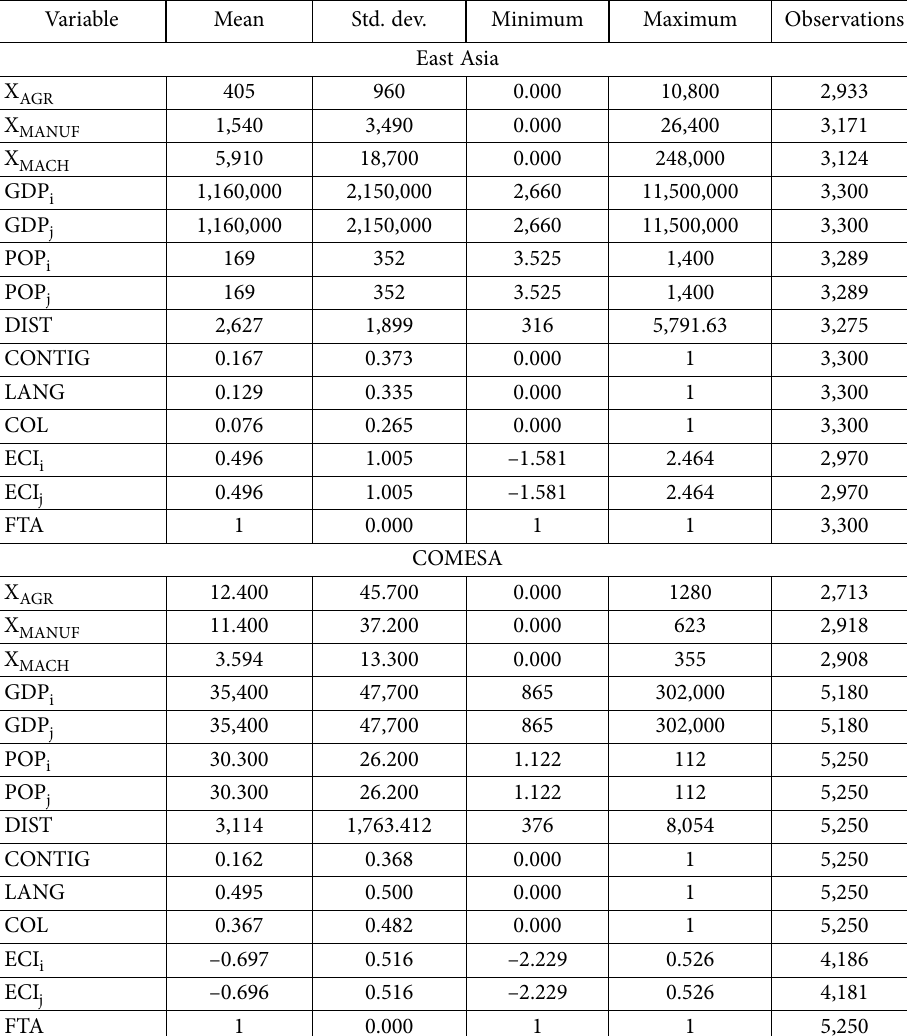
Table 3. Descriptive statistics of the